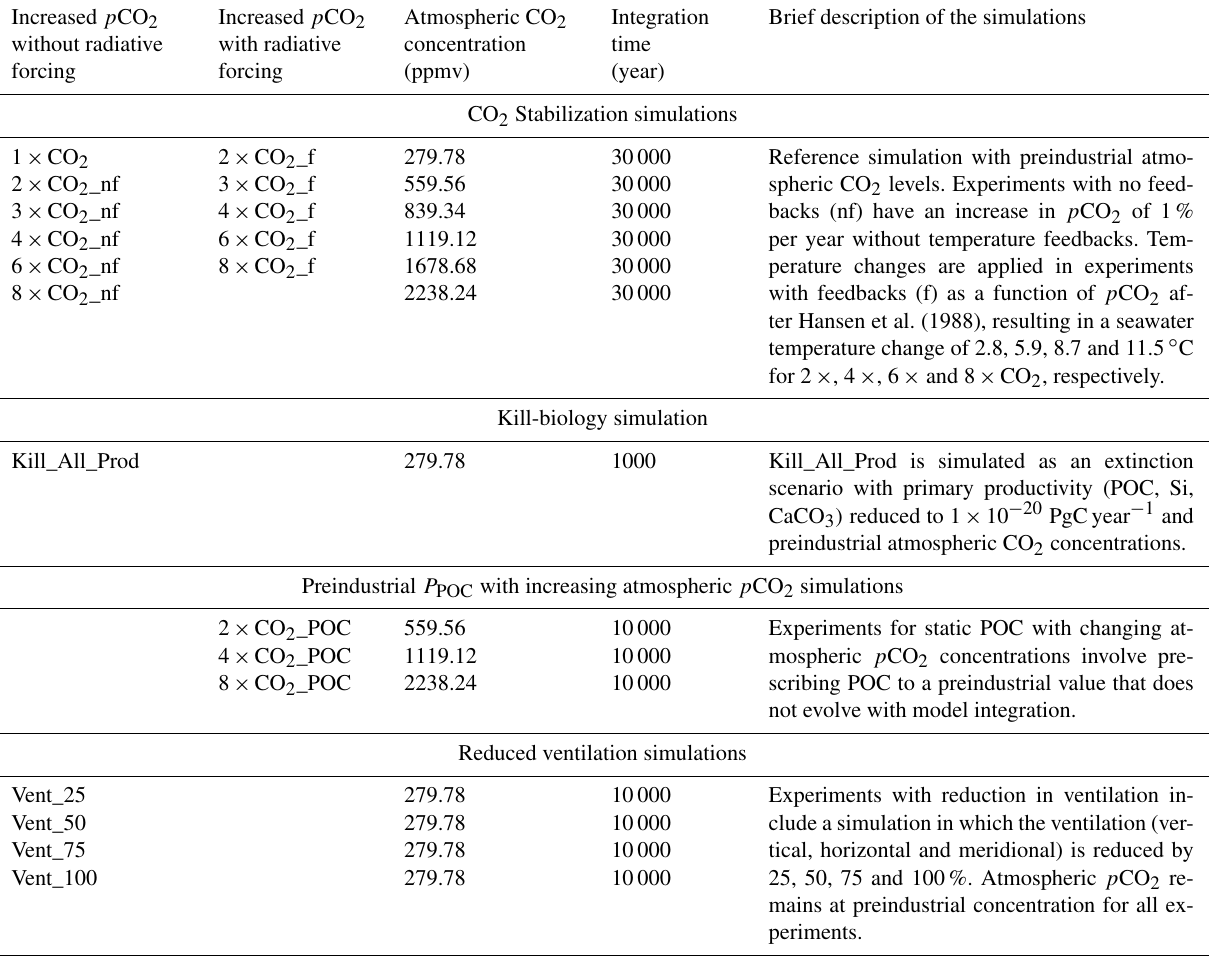
Table 2. List of model scenarios.